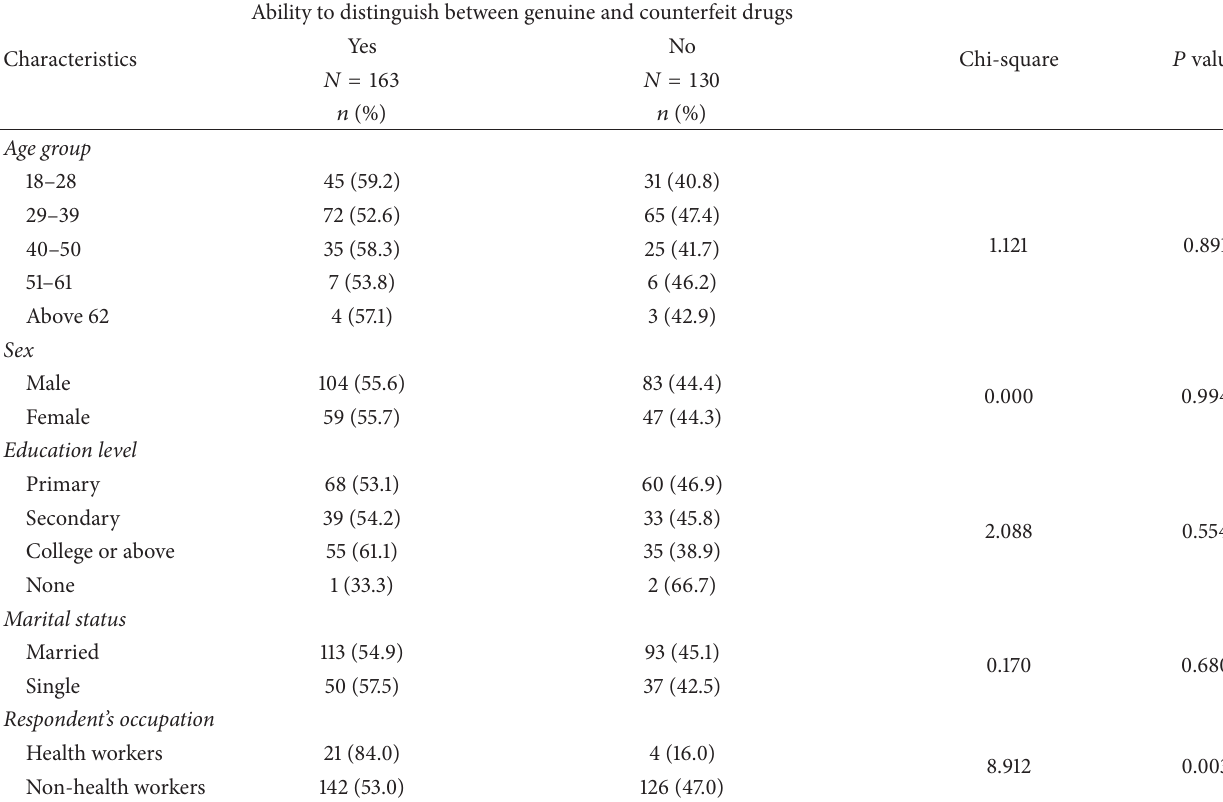
Table 2: Sociodemographic characteristics of the respondents and the ability to distinguish between genuine and counterfeit drugs.